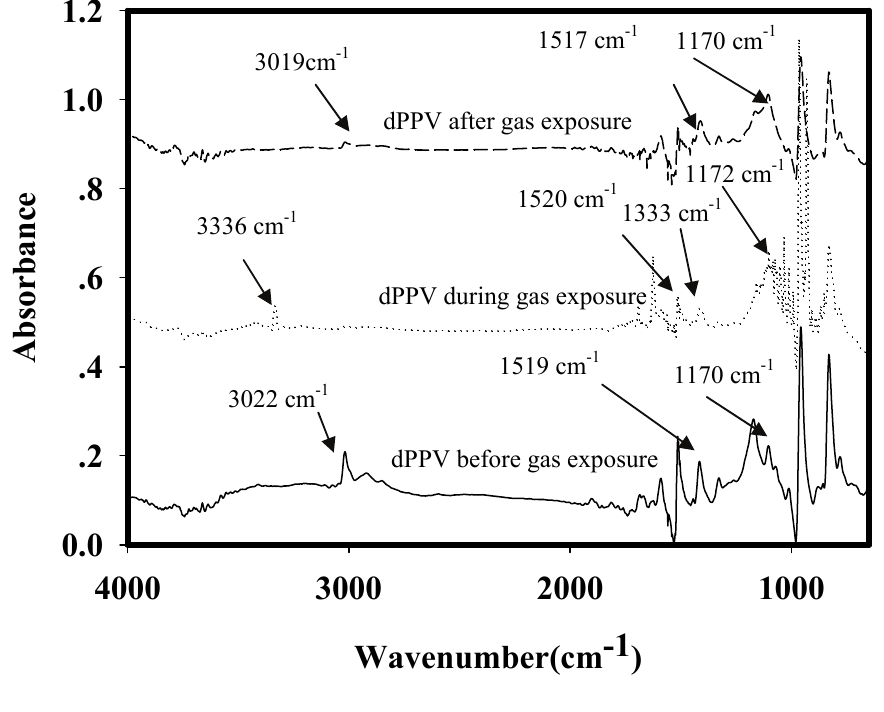
Figure 6. IR spectra of the doped PPV exposed to NH at 1 atm, and at T = 25